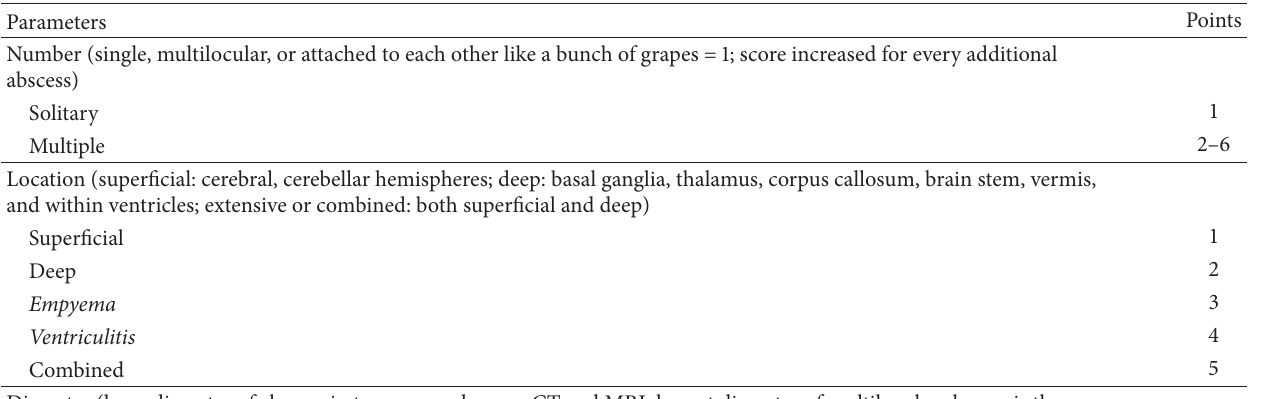
Table 4: Image severity index score [3] and proposed modifications in italic